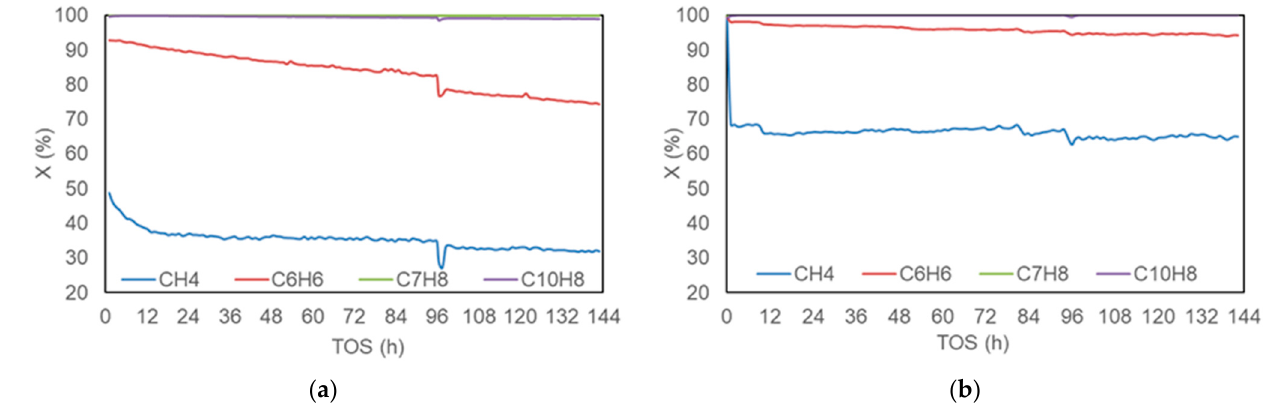
Figure 4. Hydrocarbon conversions as a function of operation time in ( a ) run 31 with rhodium catalyst and ( b ) run 30 with nickel catalyst. Reaction conditions: atmospheric pressure, 24,500 vol-ppm ethylene, 950 °C, TOS 144 h and gas composition 2. Ethylene is not presented, as the conversion was 100% through the test runs.